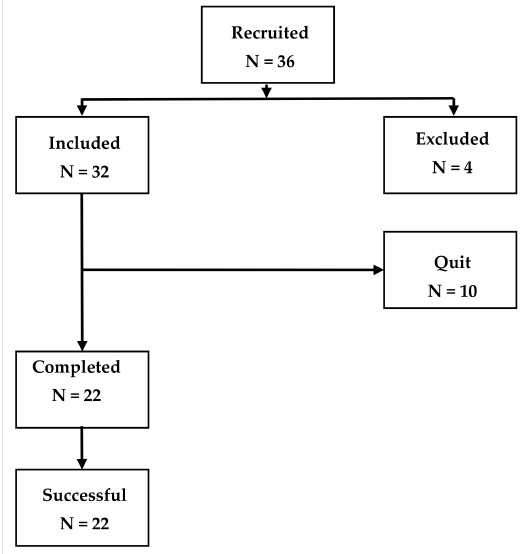
Figure 1. Flow diagram of participants in this